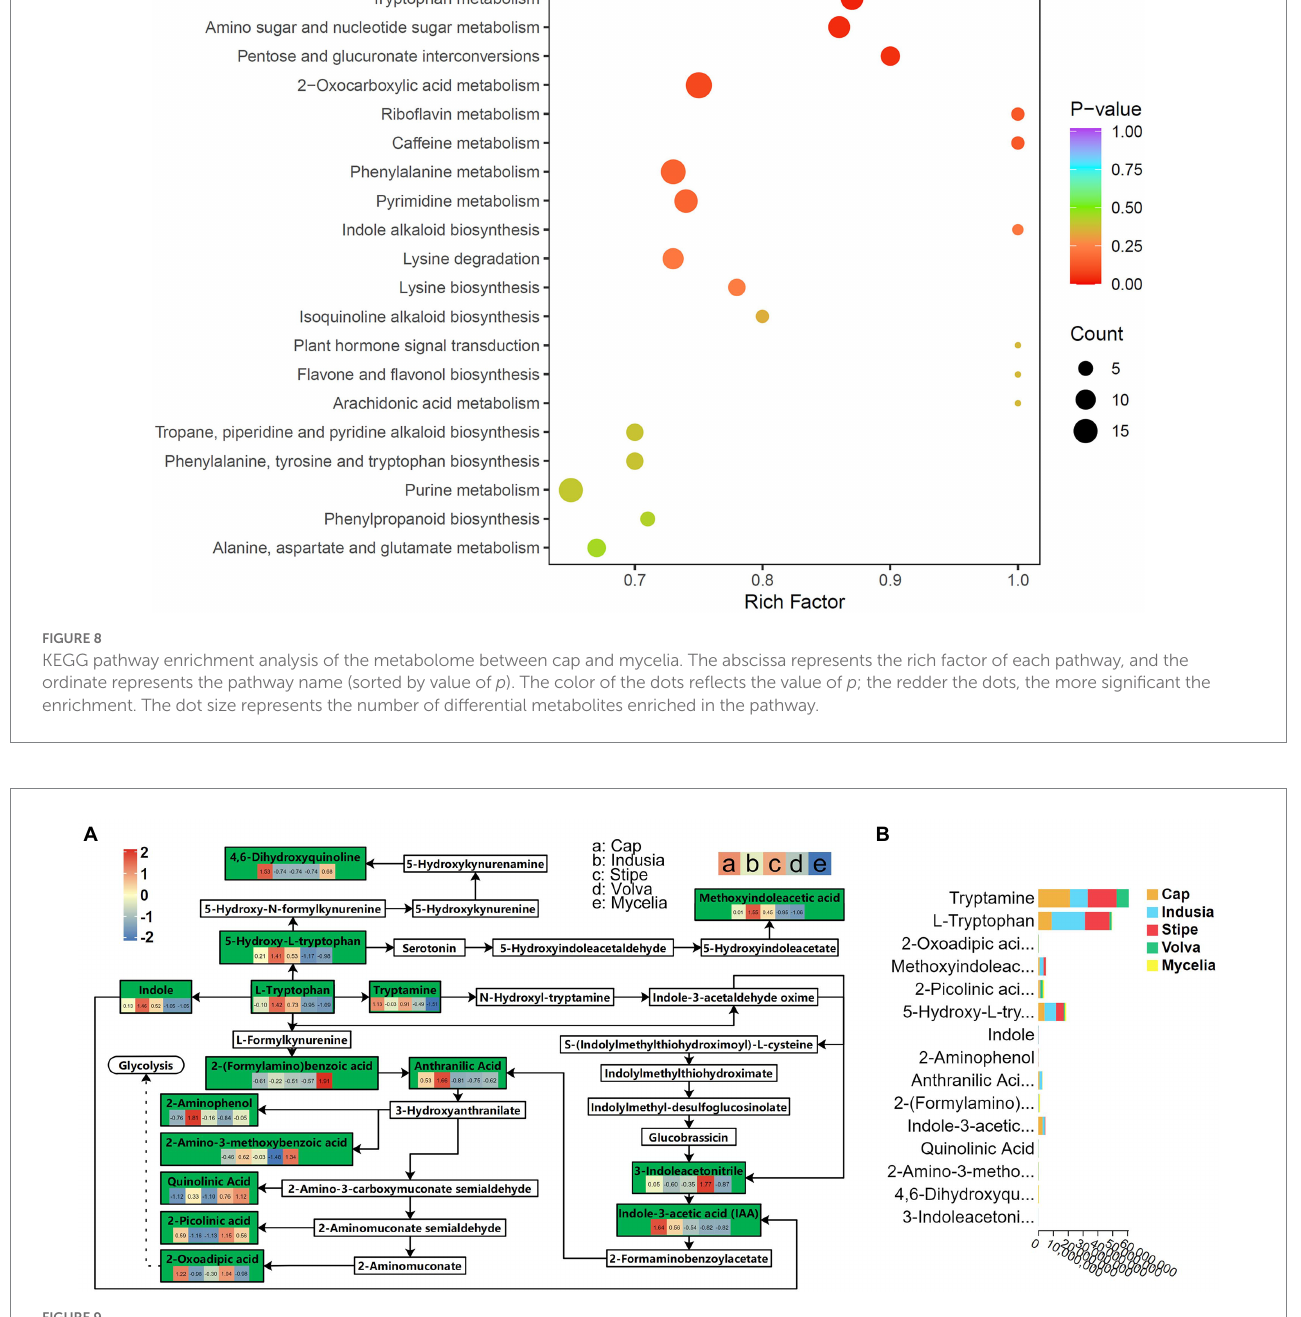
(Figure 10E, p = 0.02). Further, we classified the association between these 50 DEGs and 13 metabolites based on Pearson’s correlation analysis. as shown in Figure 10F; Supplementary Table S8; 30 DEGs were significantly associated with four